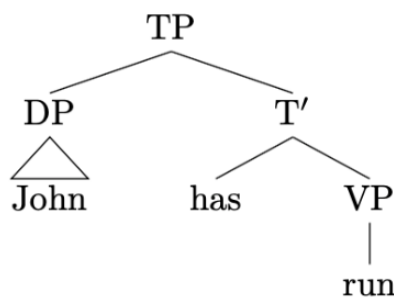
Figure 8. Elementary tree following [32, 33]